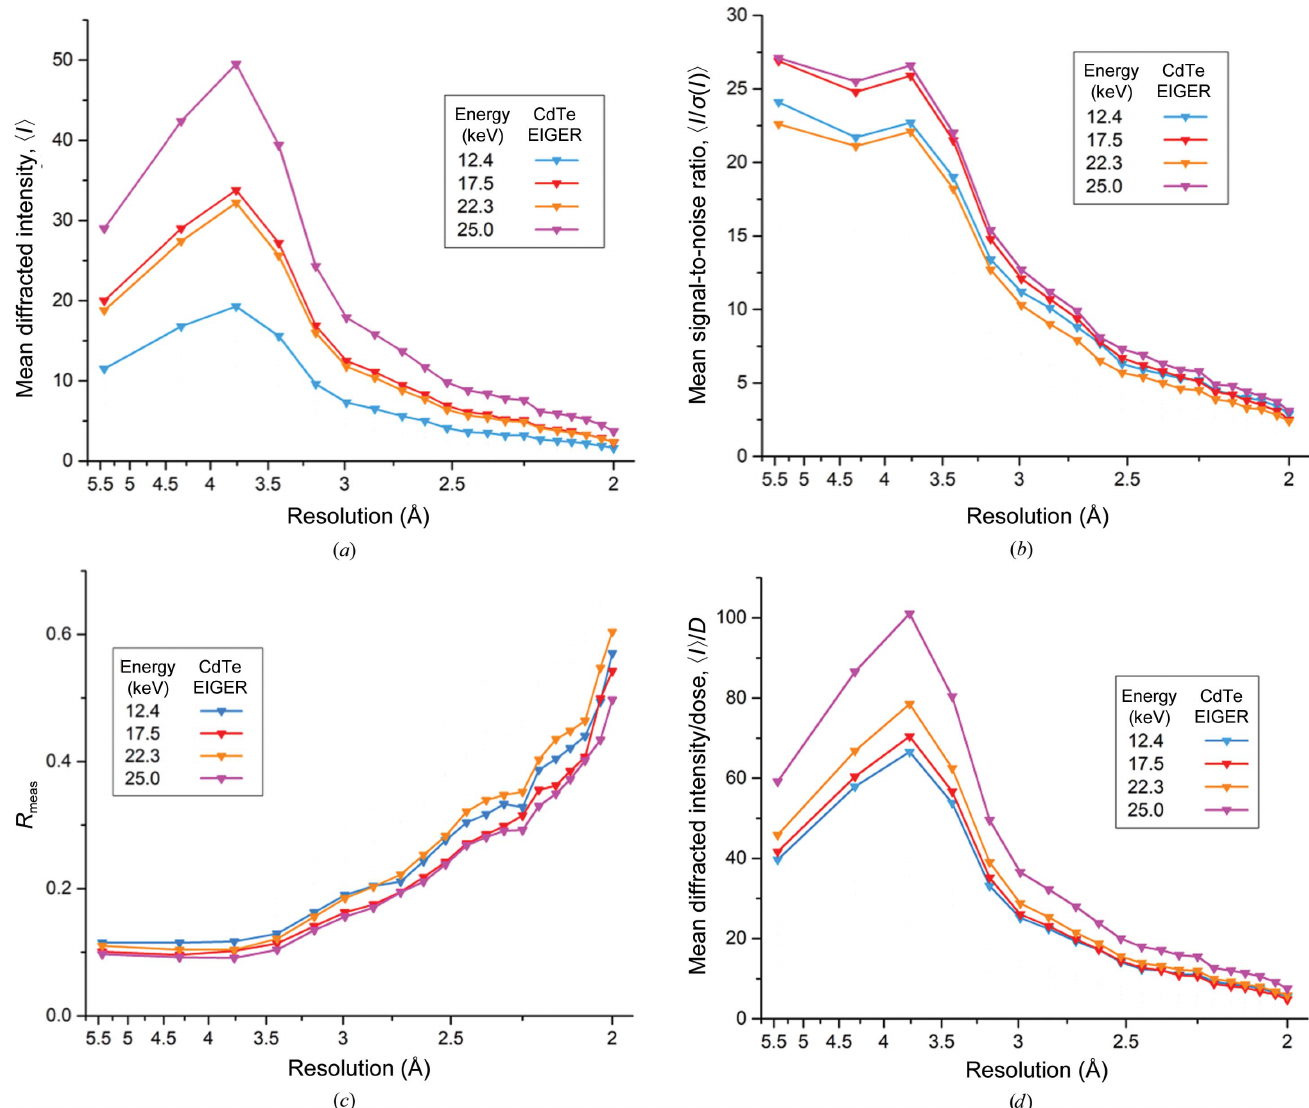
Figure 3 Overview of a data series collected using the CdTe EIGER detector, illustrating the impact of higher X-ray energies and detector sensor material. ( a) shows the mean unscaled intensity per Bragg spot h I i as a function of resolution. ( b ) Mean unscaled signal-to-noise ratio per Bragg spot h I / (cid:6) ( I ) i . ( c ) Multiplicity-independent merging R value R meas . ( d ) Observed mean diffracted intensity per Bragg spot normalized to the absorbed dose, h I i / D . In all panels the data points reflect the high-resolution limit of each shell; the lowest resolution data point includes reflections over the range 40–5.5 A˚